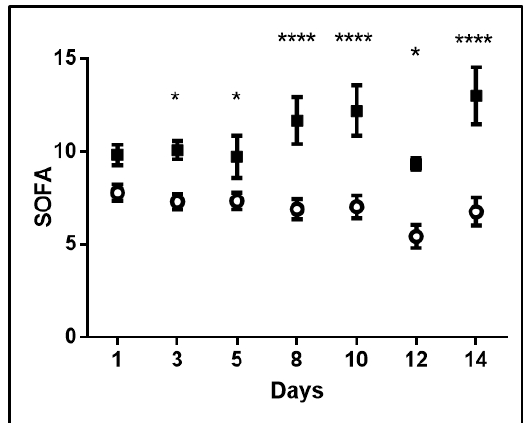
Figure 4. SOFA scores in survivors and non-survivors. SOFA scores and 28-day ICU mortality. Analysis was performed using mixed model fixed effect analysis for SOFA scores measured on admission, and days 3, 5, 8, 10, 12, and 14, using 28-day ICU mortality as the grouping factor. Open circle, survivors; closed square, non-survivors. * p < 0.05, **** p < 0.0001.